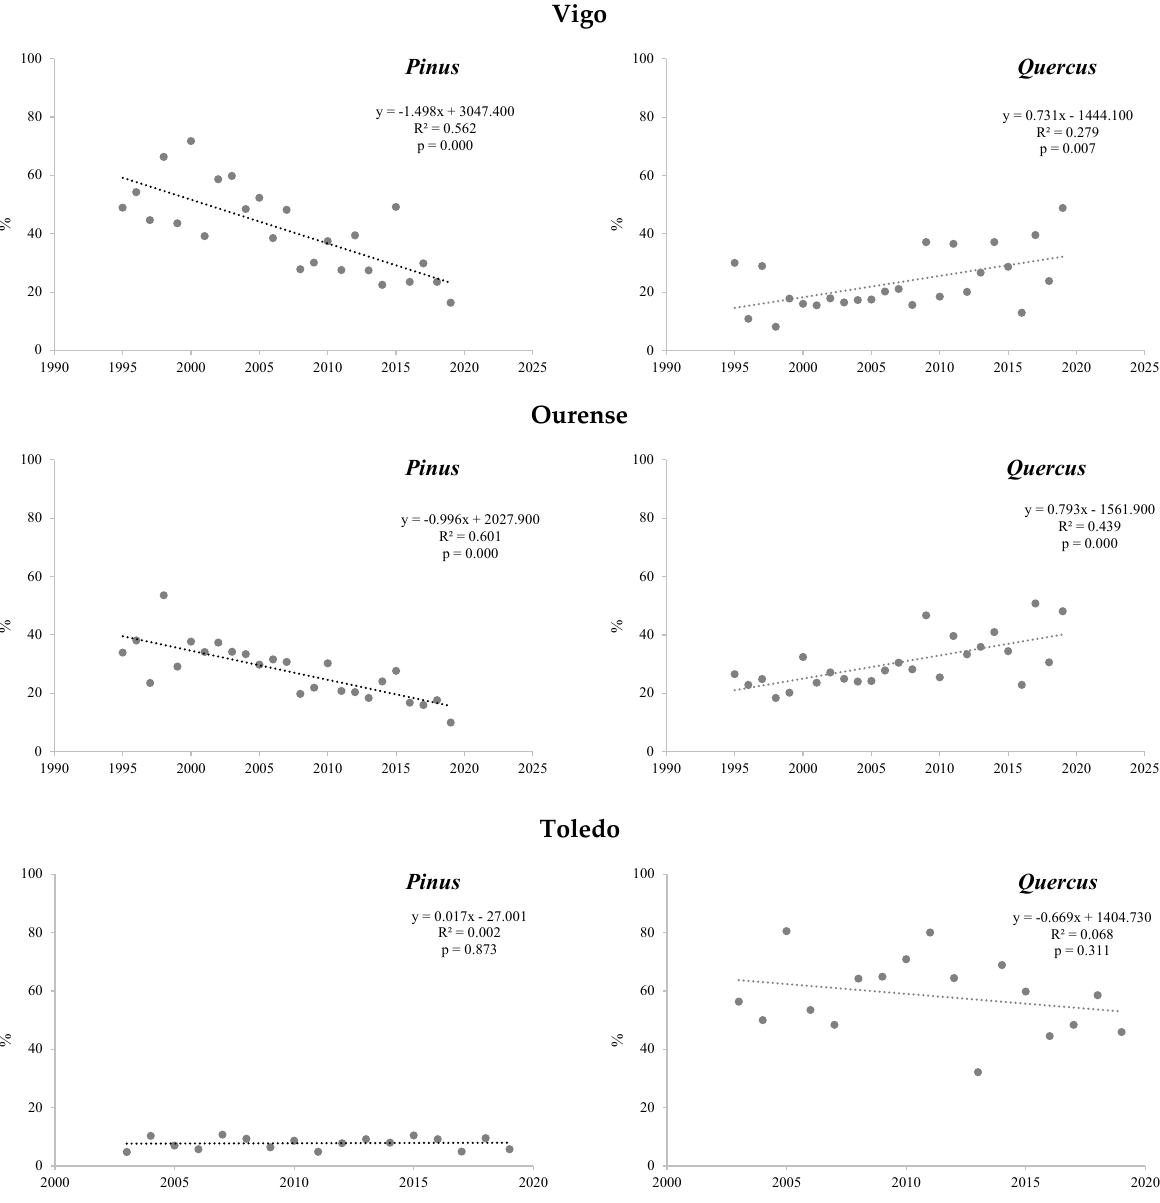
Figure 3. Trend of the percentage of airborne Pinus pollen concentration compared to the total forest tree species airborne pollen content during the entire study period in each study area.